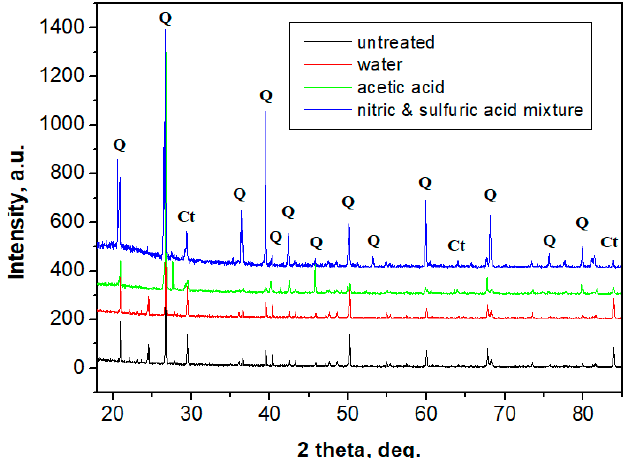
Figure 13. XRD patterns obtained for the interior porous area of the ( a ) control group; ( b ) the group exposed to rainwater; ( c ) group exposed to acetic acid; and ( d ) group exposed to nitric and sulfuric acid mixture. (Q—quartz; Ct—calcite).